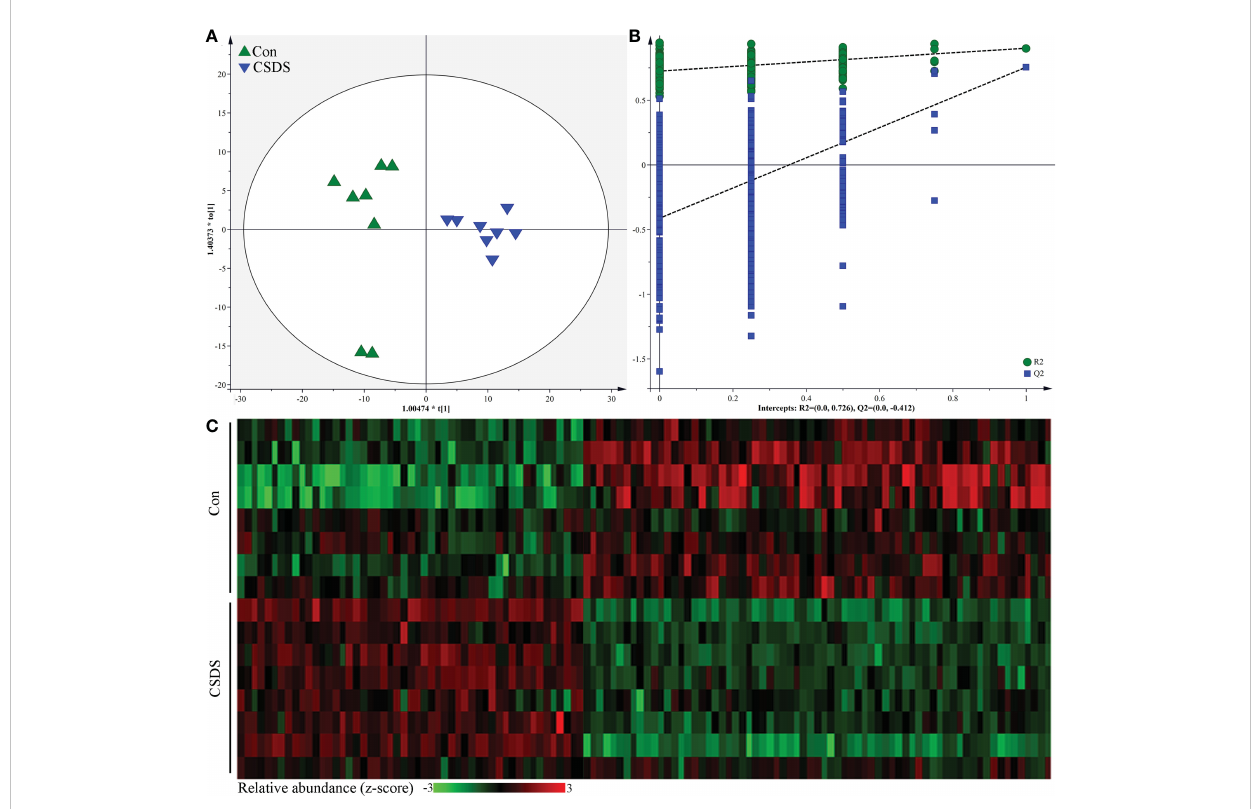
FIGURE 5 Differential microbial metabolites in CSDS mice. (A) the orthogonal partial least squares (OPLS) model showed that the two groups were signi fi cantly separated, indicating the divergent microbial metabolic phenotypes in CSDS mice; (B) the results of 399-permutation test suggested that the built OPLS model was valid and not over- fi tting; (C) heat-map of the 120 identi fi ed differential